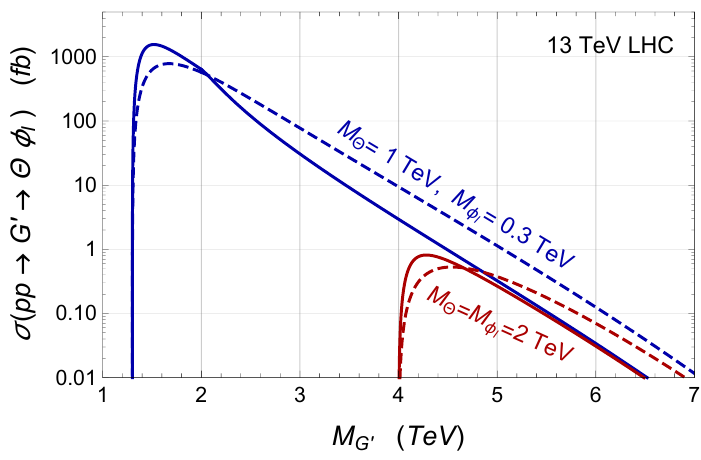
Figure 5 . Cross section for the pp G 0 (cid:2) (cid:30) I process at p s = 13 TeV as a function of the ! ! coloron mass for tan (cid:18) = 0 : 2 (solid lines) or 0.5 (dashed lines). The scalar masses are (cid:12)xed at M (cid:2) = 1 TeV and M (cid:30) = 300 GeV (blue lines), or at M (cid:2) = M (cid:30) = 2 TeV (red I I